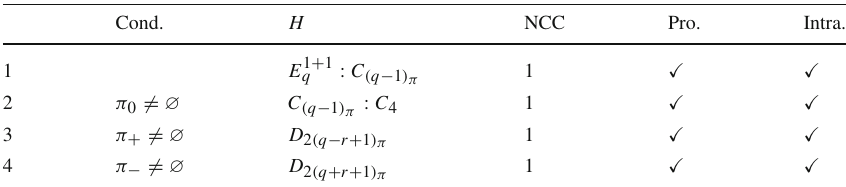
Table 8 The π -submaximal subgroups of S = Sz ( q ) , where q = 2 p , p is an odd prime. Case: 2 ∈ π . √ ( 2 q ) = 2 ( p + 1 )/ 2 π = π ∩ π( q − 1 ) , π ε = π ∩ π( q − ε r + 1 ) , ε ∈ {+ , −} . In any cases Notation: r = 0 H is π